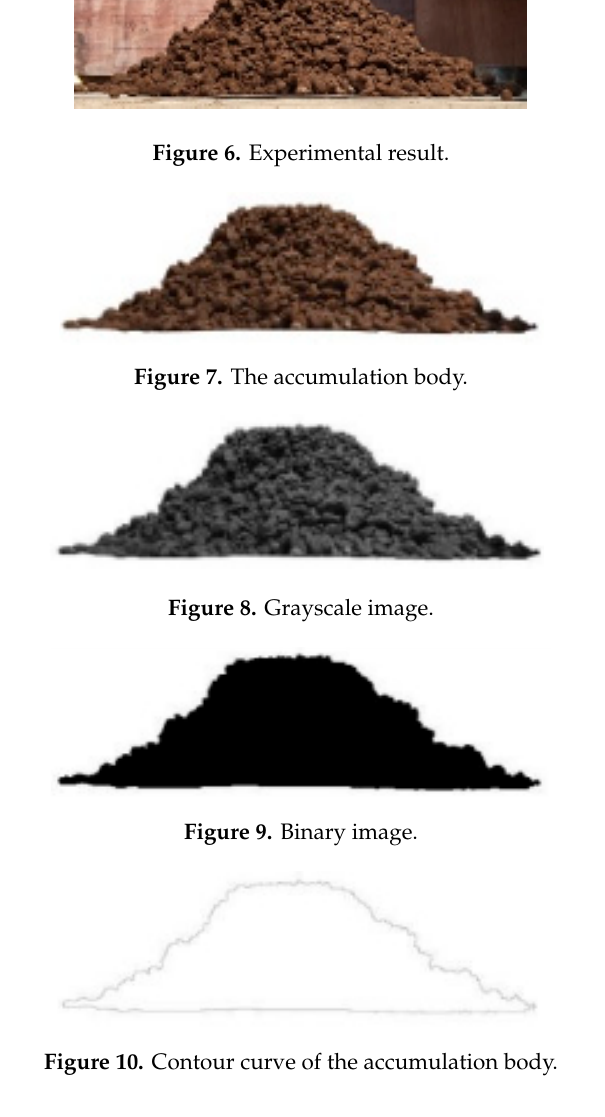
Figure 11. The fitting result of gaussian distribution function.